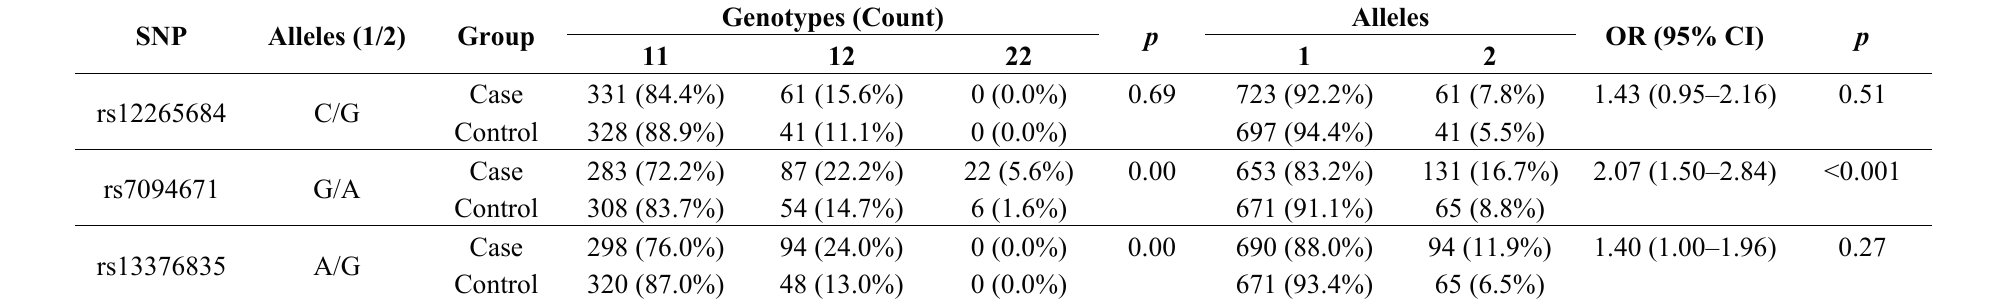
Table 2. Allele and genotype frequencies in CAD and control